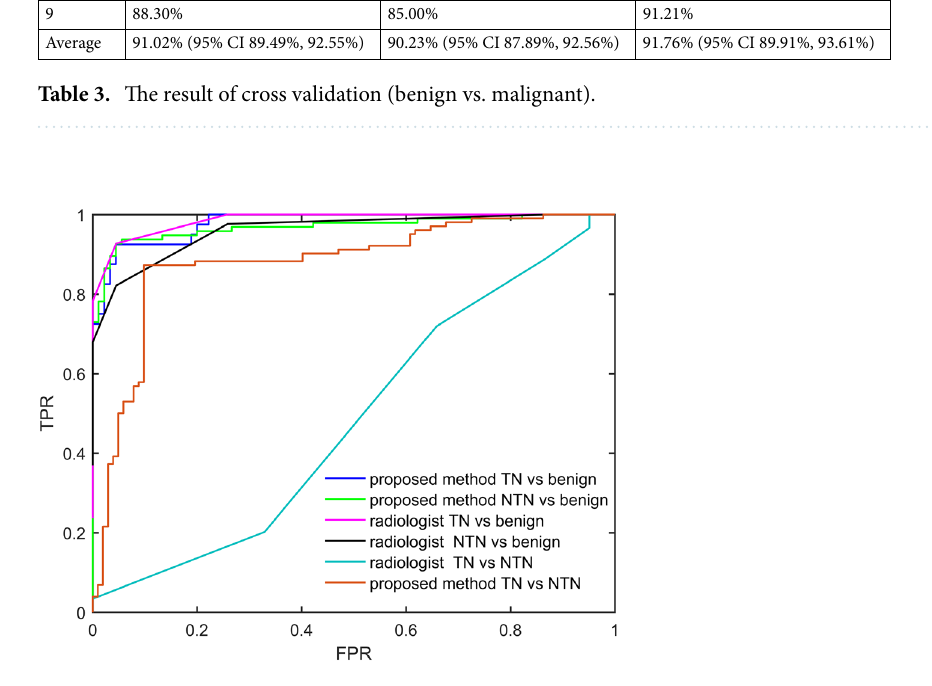
Figure 3. AUC of the proposed algorithm. TPR (True Positive Rate), FPR (False Positive